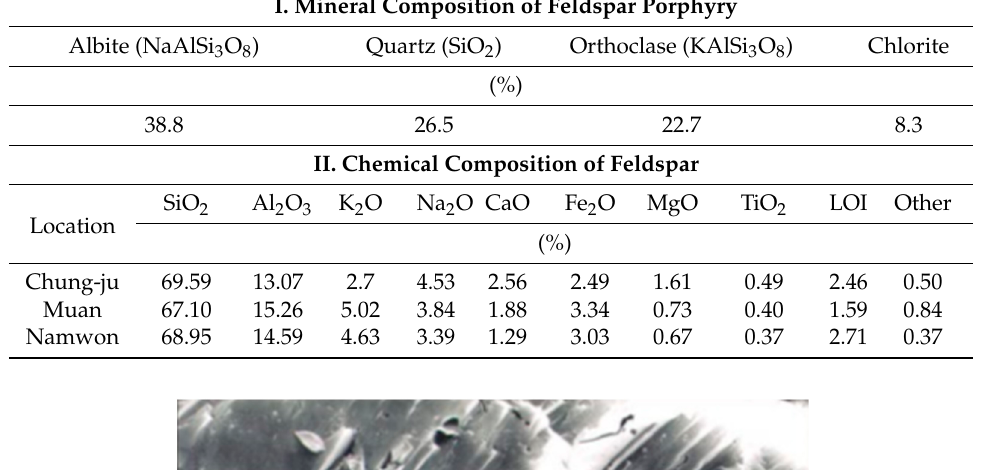
Table 1. Characteristics of experimental materials (porous feldspar).